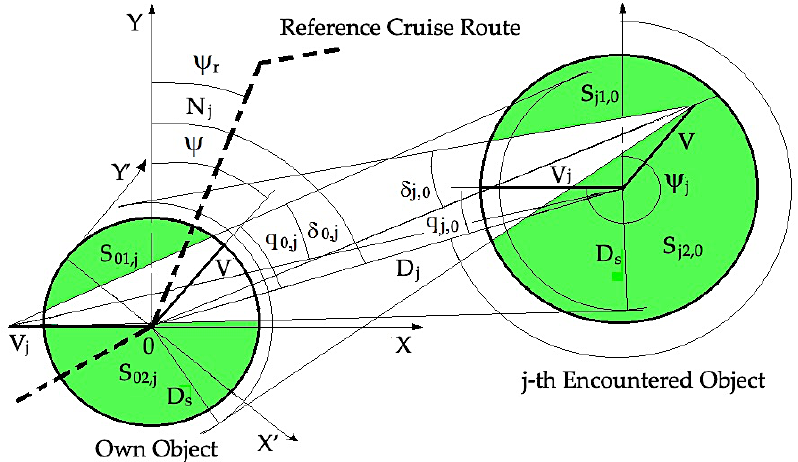
Figure 5. Graphic design of acceptable sets of strategies for own object: U 0,j = S 01,j or S 02,j and for j-th encountered object: U j,0 = S j1,0 or S j2,0